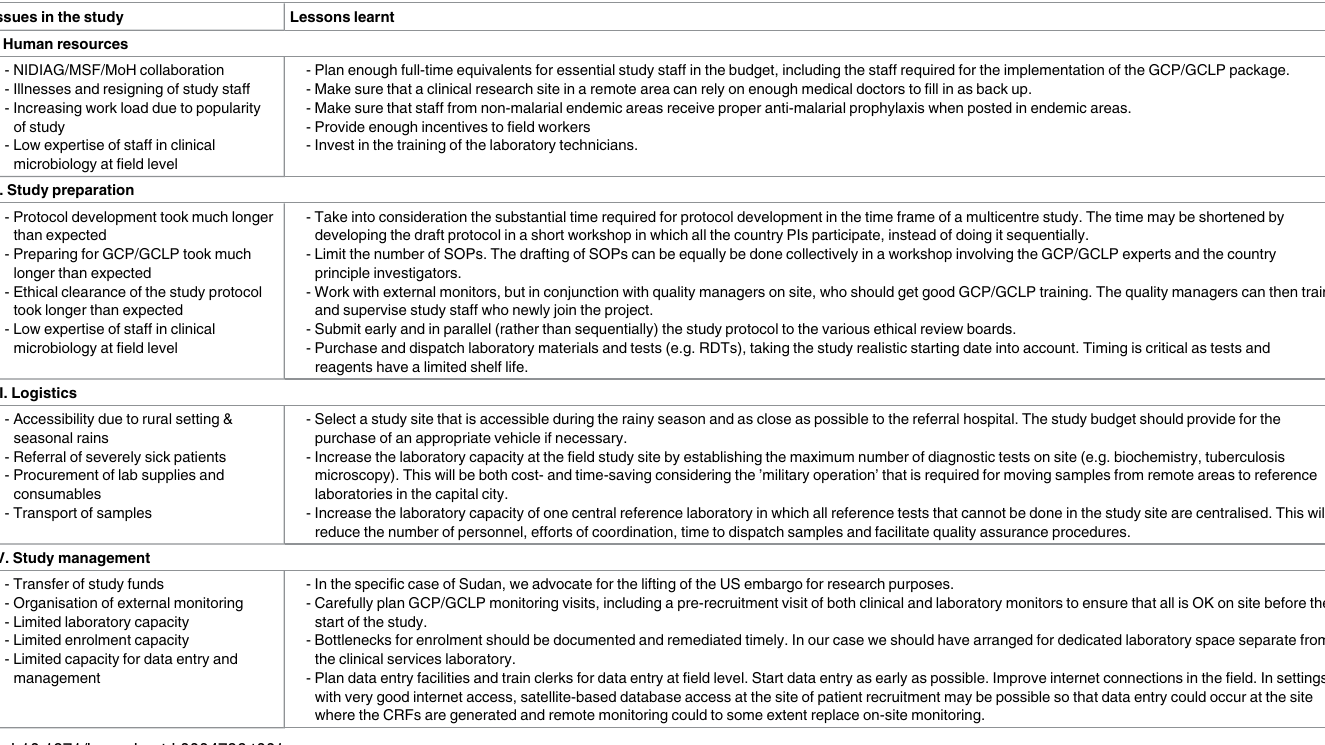
Table 1. NIDIAG study issues identified in Sudan and lessons